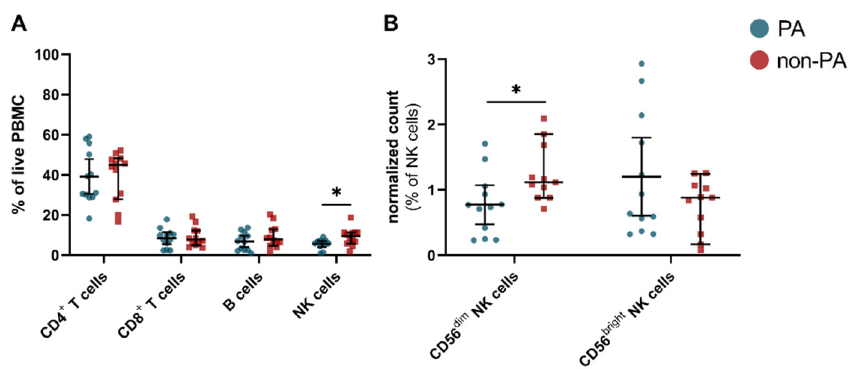
Figure 1. NK cell patterns in idiopathic inflammatory myopathies. ( A ) Relative cell numbers of leukocytes. ( B ) Relative cell numbers of CD16 + NK cell subsets after normalization. CD56 dim CD16 dim NK cells were excluded. Differences were determined by Mann–Whitney test for PA (blue) and non-PA (red). To account for multiple comparisons, statistical significance was corrected by the false discovery rate (FDR). A threshold of Q = 5% was used for FDR. Error bars display mean (IQR). Abbreviations: NK = natural killer, PA = pulmonary affection, PBMC = peripheral blood mononuclear cell * p < 0.05.